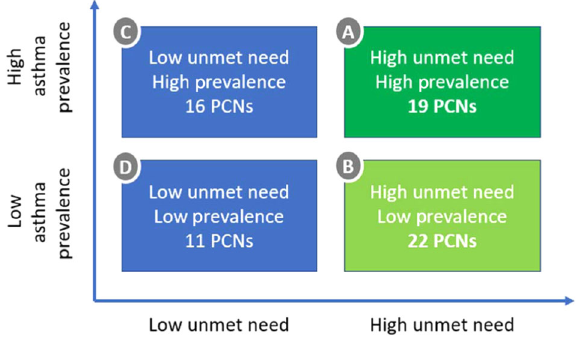
Fig. 1 Matching Asthma Need With Prevalence. Grouping of PCNs by unmet need and asthma prevalence in the STARRS-GM